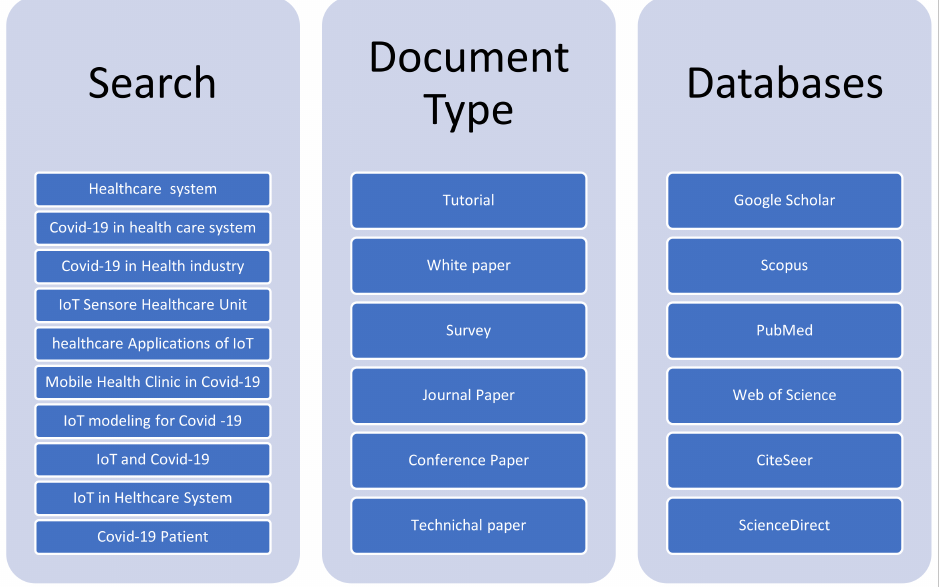
Figure 3. Data Collection